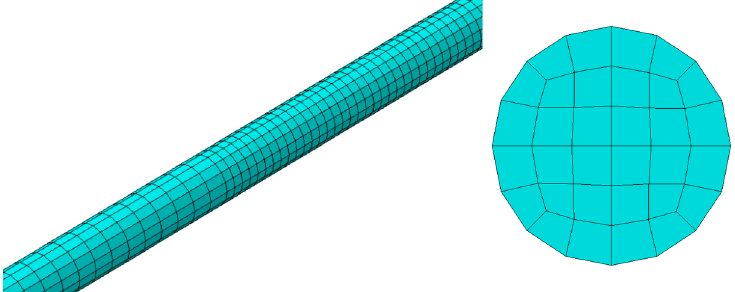
Figure 5. Overall mesh of the bolt ( left ); cross-section of the bolt ( right ).